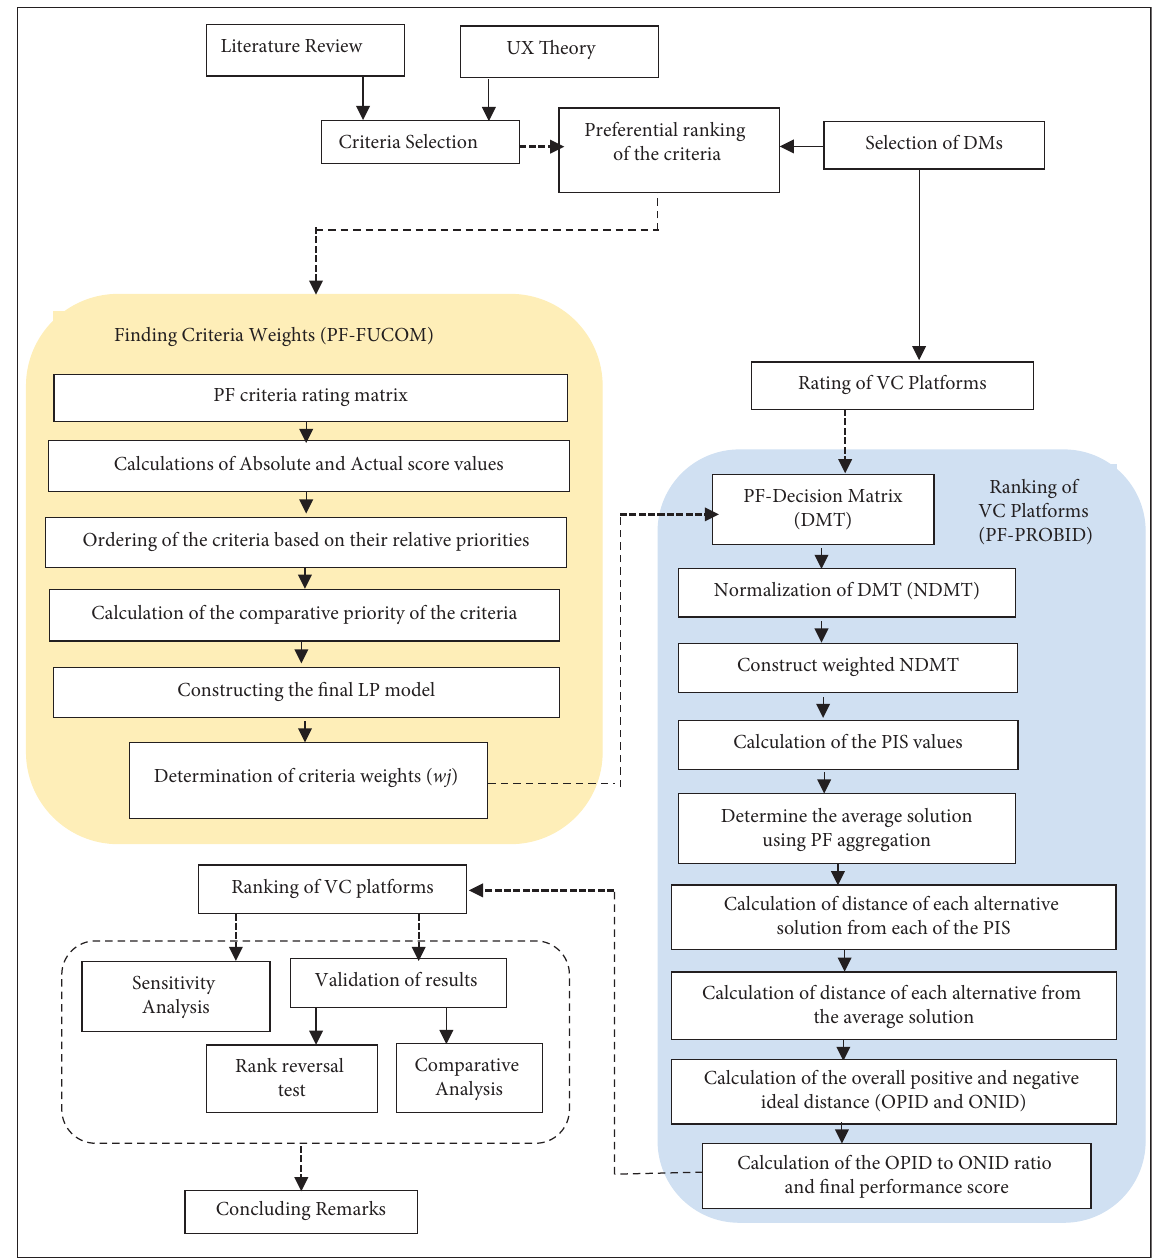
Figure 1: Flow of steps of the research framework.